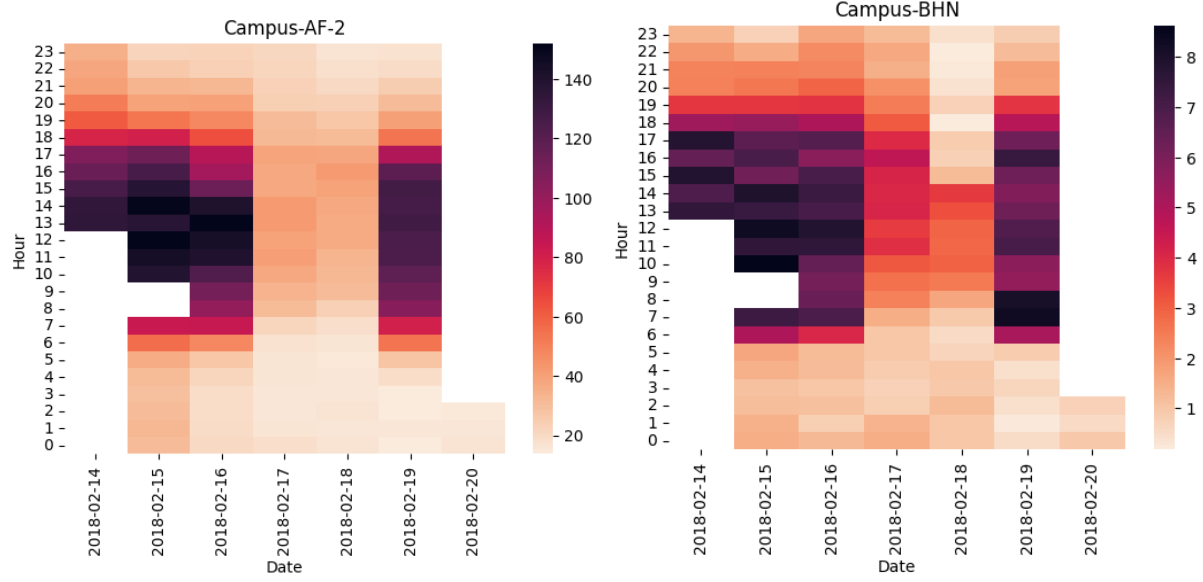
Figure 14. Heat maps of number of WiFi devices at two selected